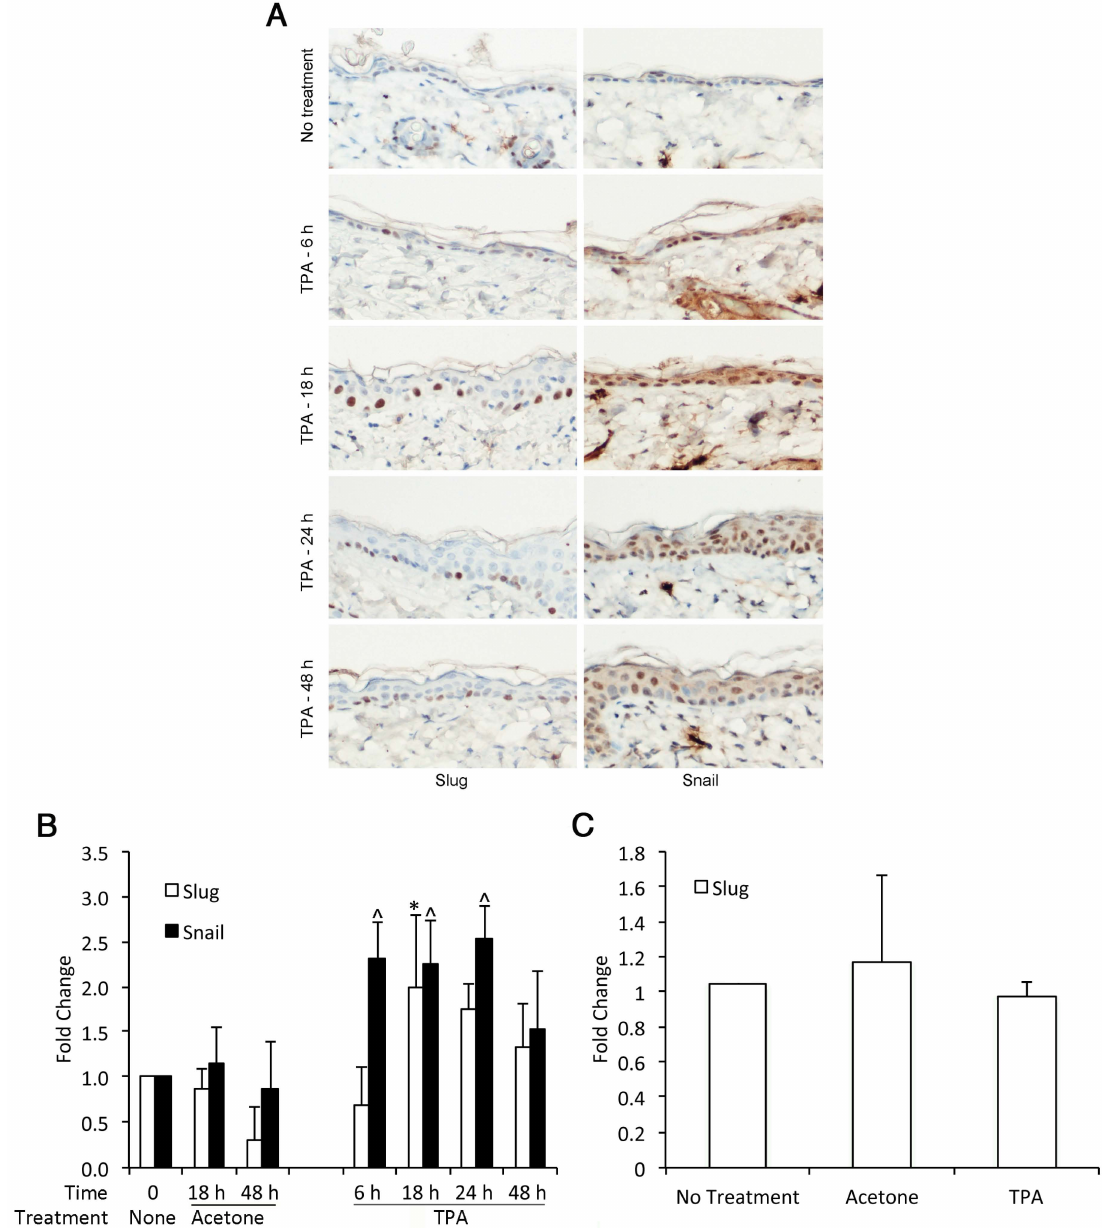
Figure 2. TPA induces Slug and Snail expression in the skin of mice. The shaved backs of 6–8-week-old female FVB mice were treated once with 2.5 µ g TPA in acetone. Skin was harvested at different times after TPA application, and immunohistochemistry for Slug and Snail was performed. ( A ) Representative examples of immunohistochemical staining. ( B ) For quantification of Slug- and Snail-positive nuclei in TPA-treated skin, digitized slides were analyzed using the GENIE morphometry program, and the number of positive nuclei per mm was normalized to the number of positive nuclei in untreated skin. Results were compared by ANOVA followed by the Bonferroni correction. * Significantly elevated compared to 18 h and 48 h acetone-treated skin and 6 h TPA-treated skin. ˆ Significantly different from 18 h and 48 h acetone-treated skin. Bars indicate SD. ( C ) Epidermal Slug and Snail mRNA levels at 18 h after TPA treatment were quantified. Snail mRNA was undetectable, while Slug levels were similar in untreated, acetone-treated and TPA-treated